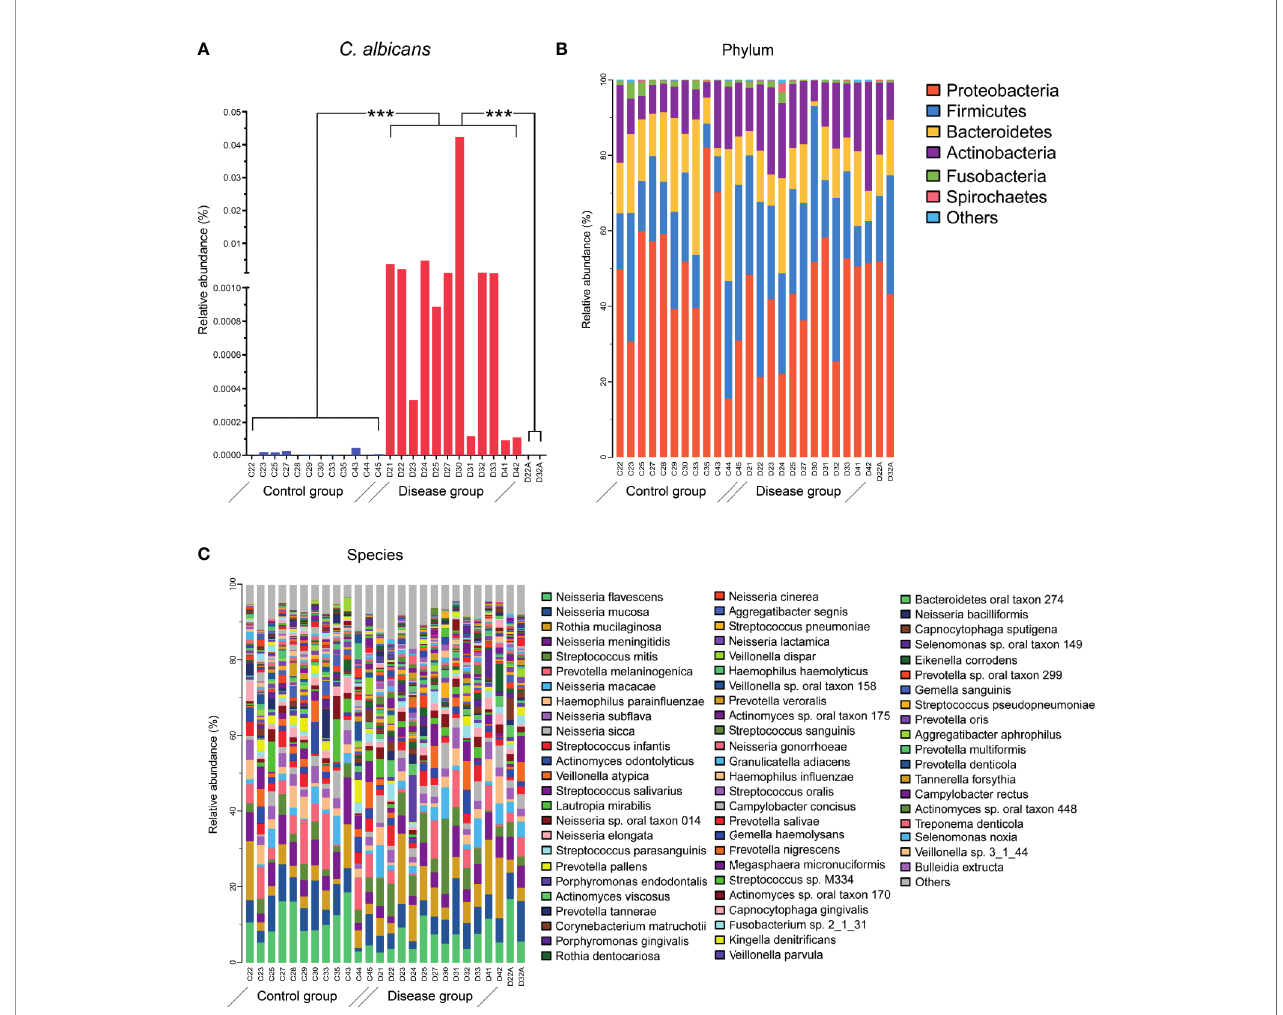
FIGURE 2 | Microbial compositions of salivary samples. (A) The relative abundance of C. albicans was signi fi cantly different between the HC and DIS groups. *** P <0.001. (B) The relative abundance levels of bacteria at the phylum levels. (C) The relative abundance levels of bacteria at the species levels. Sequence annotation and relative abundance estimation were performed with